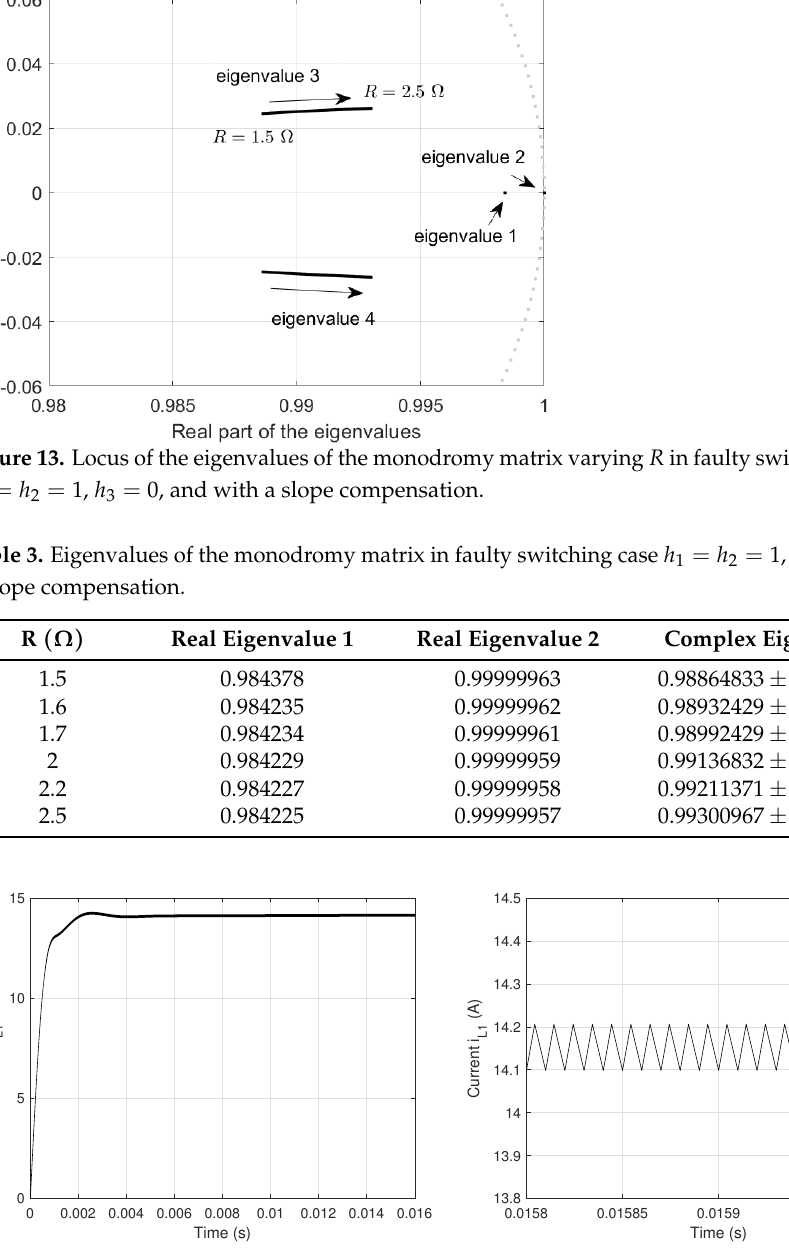
Figure 14. Time − domain waveforms for R = 1.5 Ω in faulty switching case h 1 = h 2 = 1, h 3 = 0, and with a slope